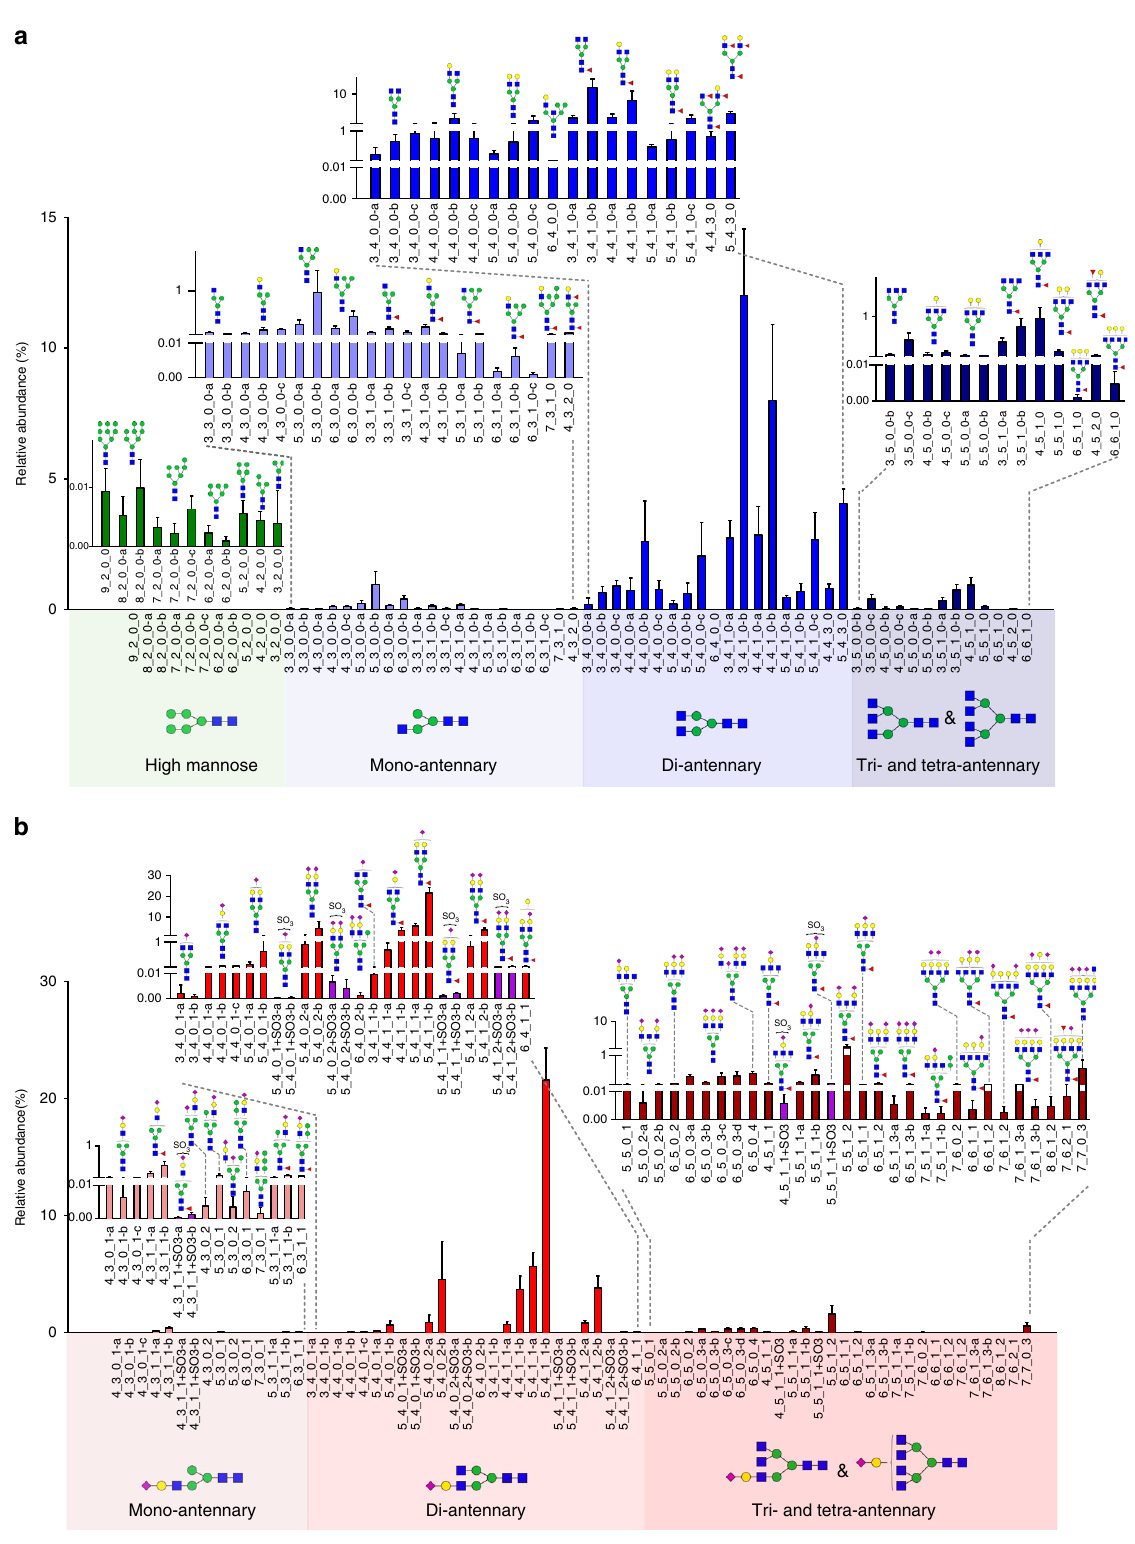
Fig. 6 Glycomic analysis of human serum IgGs using MRM method. It revealed a highly dynamic range of up to fi ve orders of magnitude in the relative abundances of both neutral a and acidic b N-glycans, data are shown as mean ±